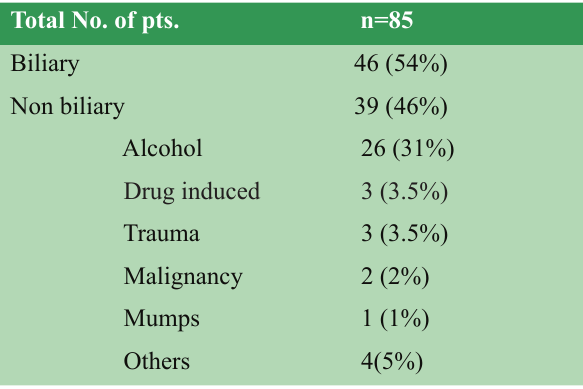
Table 1: Etiology of acute pancreatitis Total No. of pts.